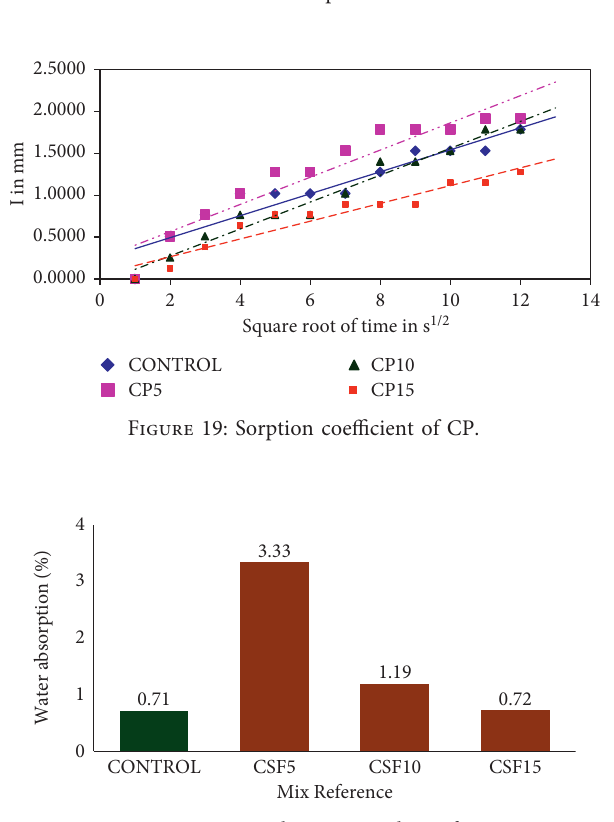
Figure 18: Water absorption values of CP.